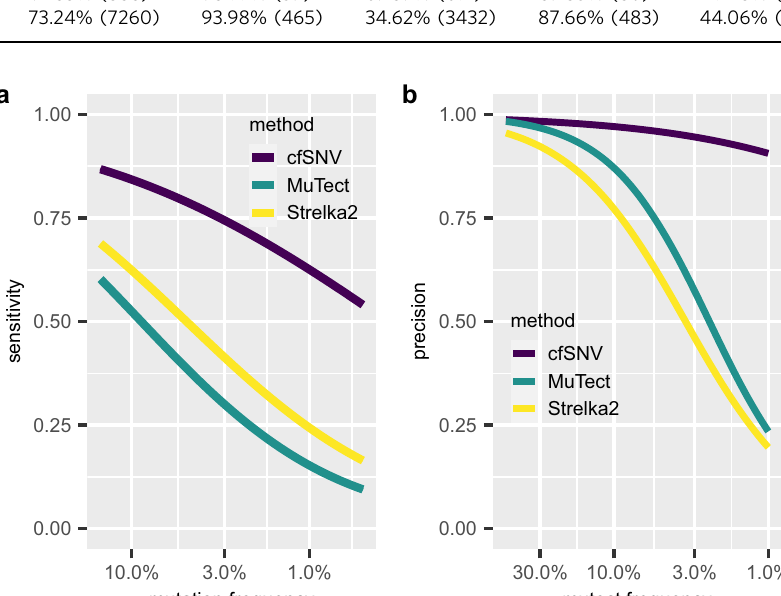
Fig. 2 cfSNV outperforms competing methods in sensitivity and precision, especially for low-frequency mutations (VAF < 5%). a The sensitivity of three variant calling methods on simulation data ( n = 6) as a function of VAF for cfSNV, MuTect, and Strelka2. Mutations were grouped based on their simulated VAF, and the sensitivity at each simulated VAF level was calculated separately. The speci fi city and the precision of all three methods remained at comparable and high level (Table 1). All curves were fi tted using logit functions. b The precision of three variant calling methods on patient data ( n = 36) as a function of VAF. Mutations detected from all samples were grouped based on their rounded VAF (two decimal places). The precision at each VAF level was estimated by the con fi rmation rate. The sensitivity of patient data cannot be quanti fi ed because of the unknown ground truth, but cfSNV detected the most true positive mutations. Note that MuTect has no result when VAF < 2% because its default con fi guration treats all mutation candidates with VAF < 2% as contamination errors, and all curves here were fi tted using logit